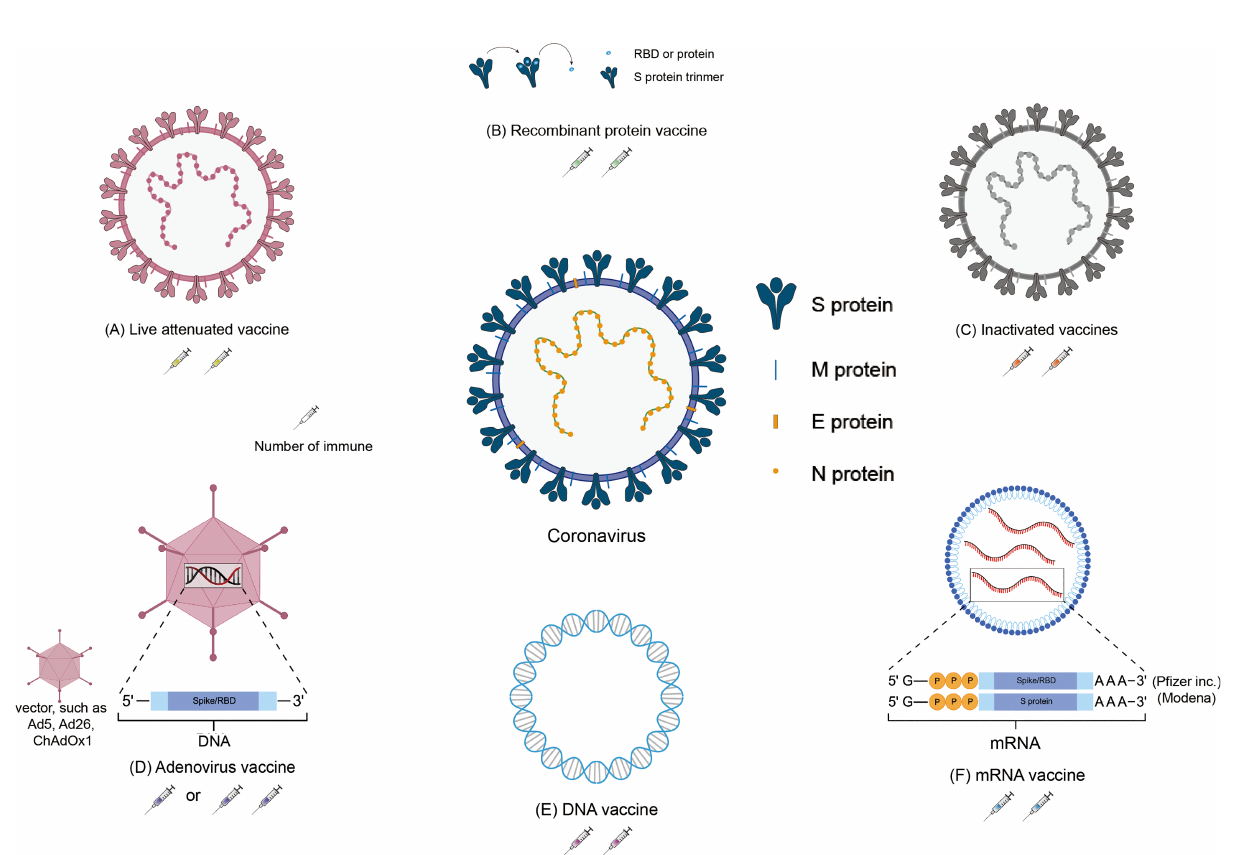
FIGURE 1 | Schematic representation of the various SARS-CoV-2 vaccines. Located in the middle of the picture is the structure of coronavirus. The structure of the vaccines and the number of immunizations: (A) Inactivated vaccine; (B) Recombinant protein vaccine; (C) Live attenuated vaccine; (D) Adenovirus vaccine; (E) DNA vaccine; (F) mRNA